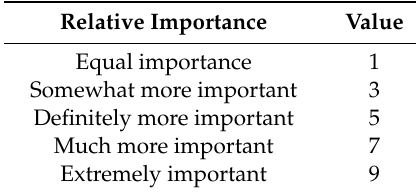
Figure 5. Fuzzy system. Figure 6. Fuzzy system. Table 6. Relative